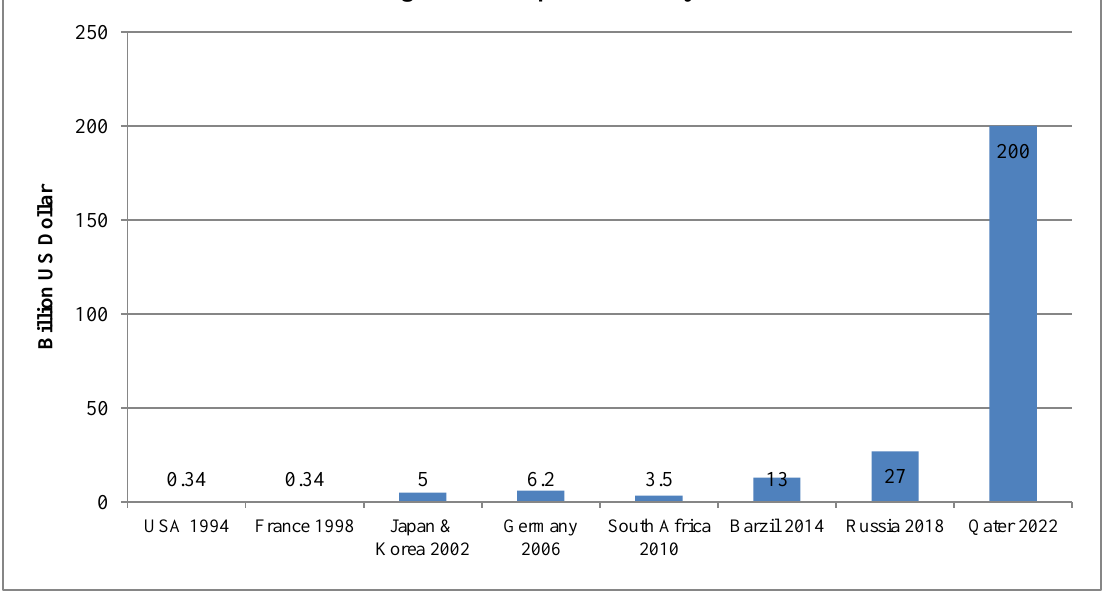
Figure 1. The cost of hosting world cup in Germany and some